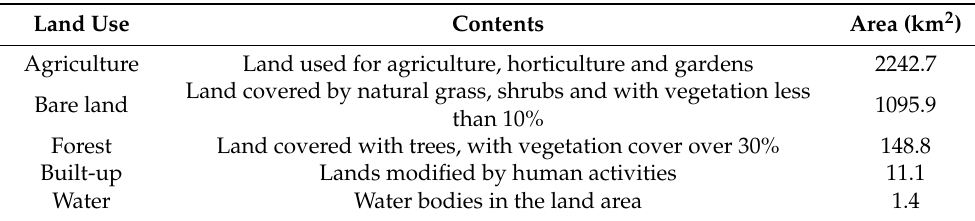
Table 1. Land-use classifications and corresponding areas in the Kesem watershed.